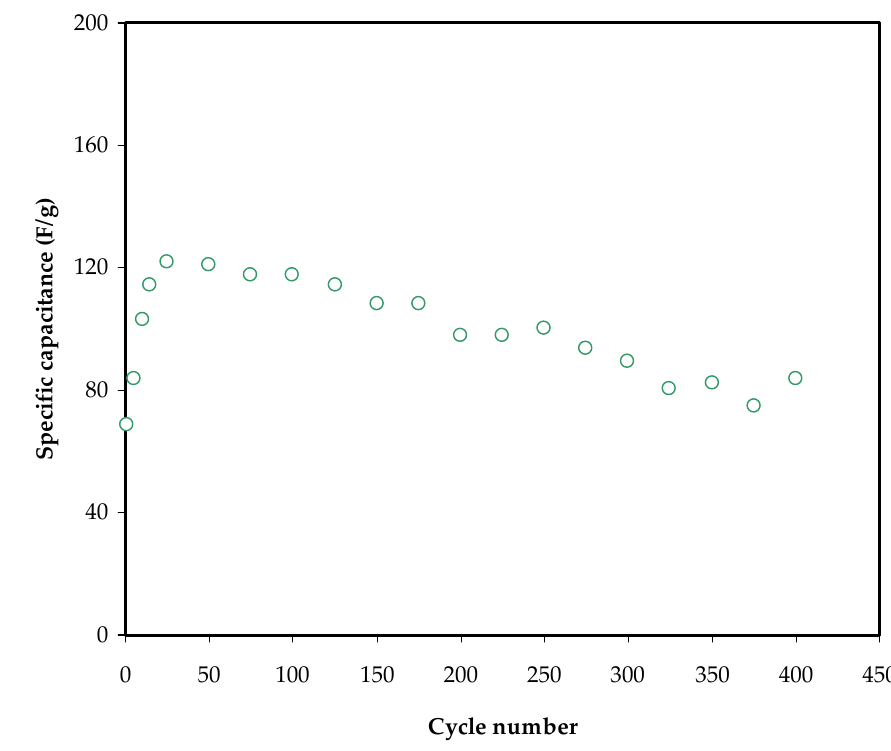
Figure 9. Variation of specific capacitance, Cs for the constructed EDLC up to 400 cycles.